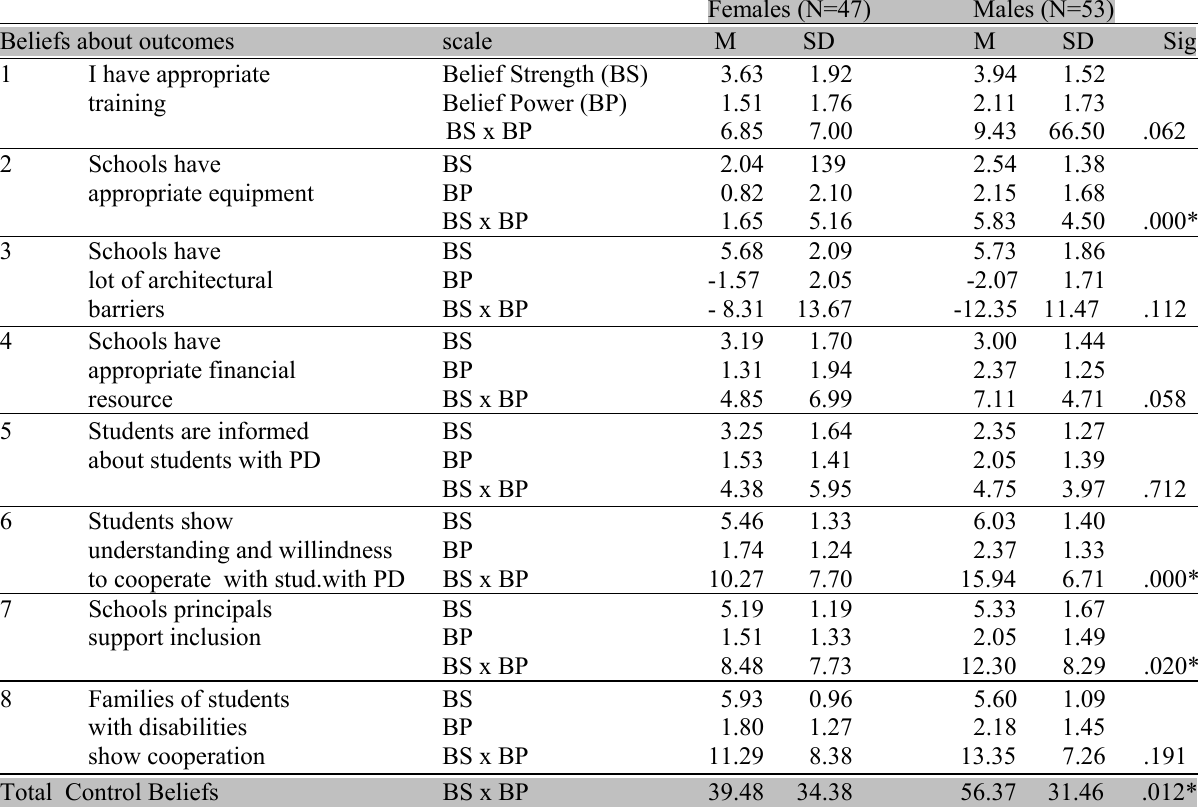
Table 3 . Scores of female and male in-service PE teachers on Control Beliefs Females (N=47) Males (N=53) Beliefs about outcomes scale M SD M SD